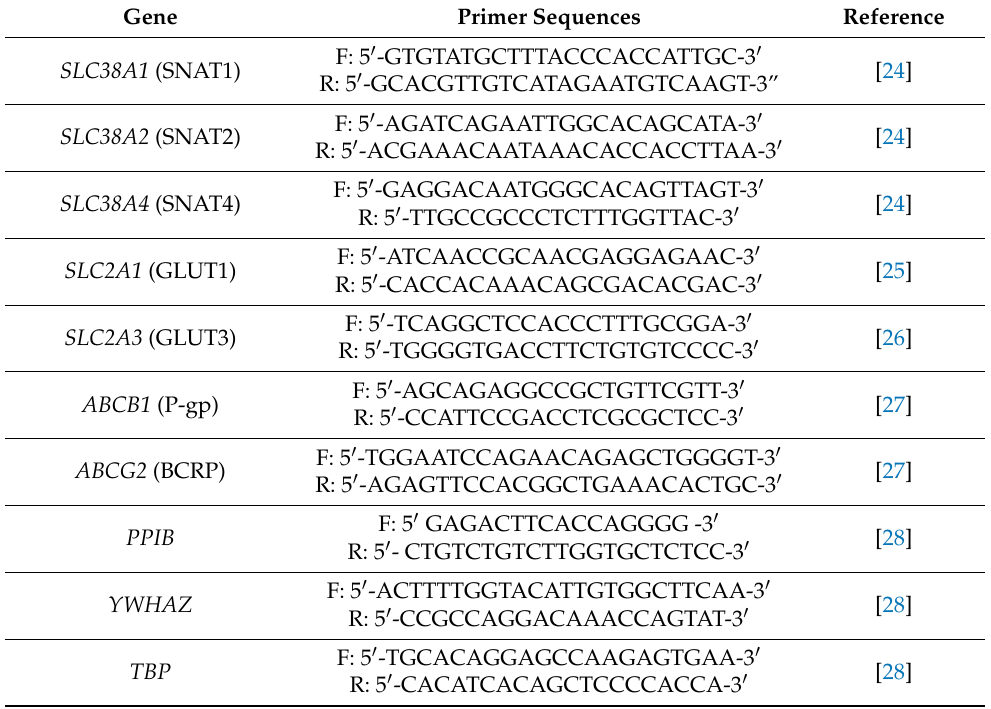
Table 1. List of Primer sequences used in this study.